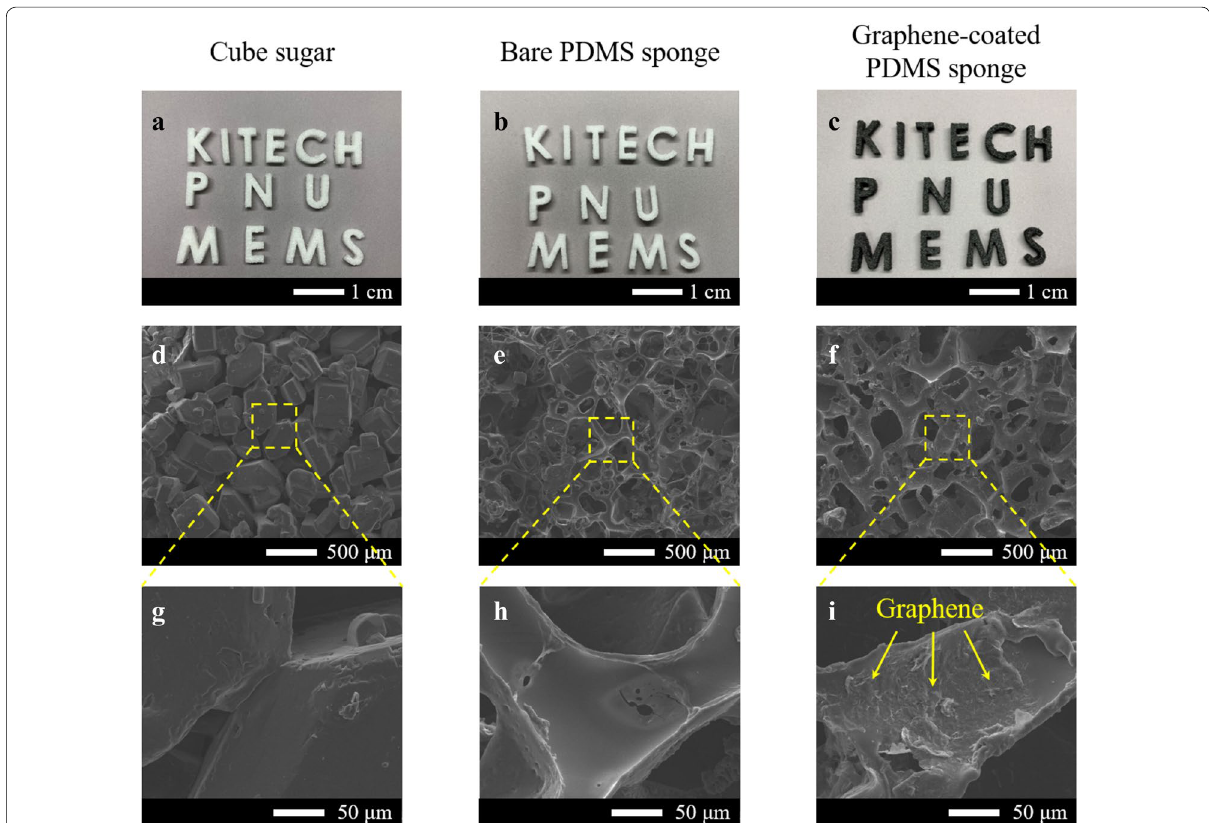
Fig. 1 Photos of a cube sugar, b bare PDMS sponge, and c graphene-coated PDMS sponge. d – i Show the SEM images of surface of cube sugar, bare PDMS sponge, and graphene-coated PDMS sponge, respectively